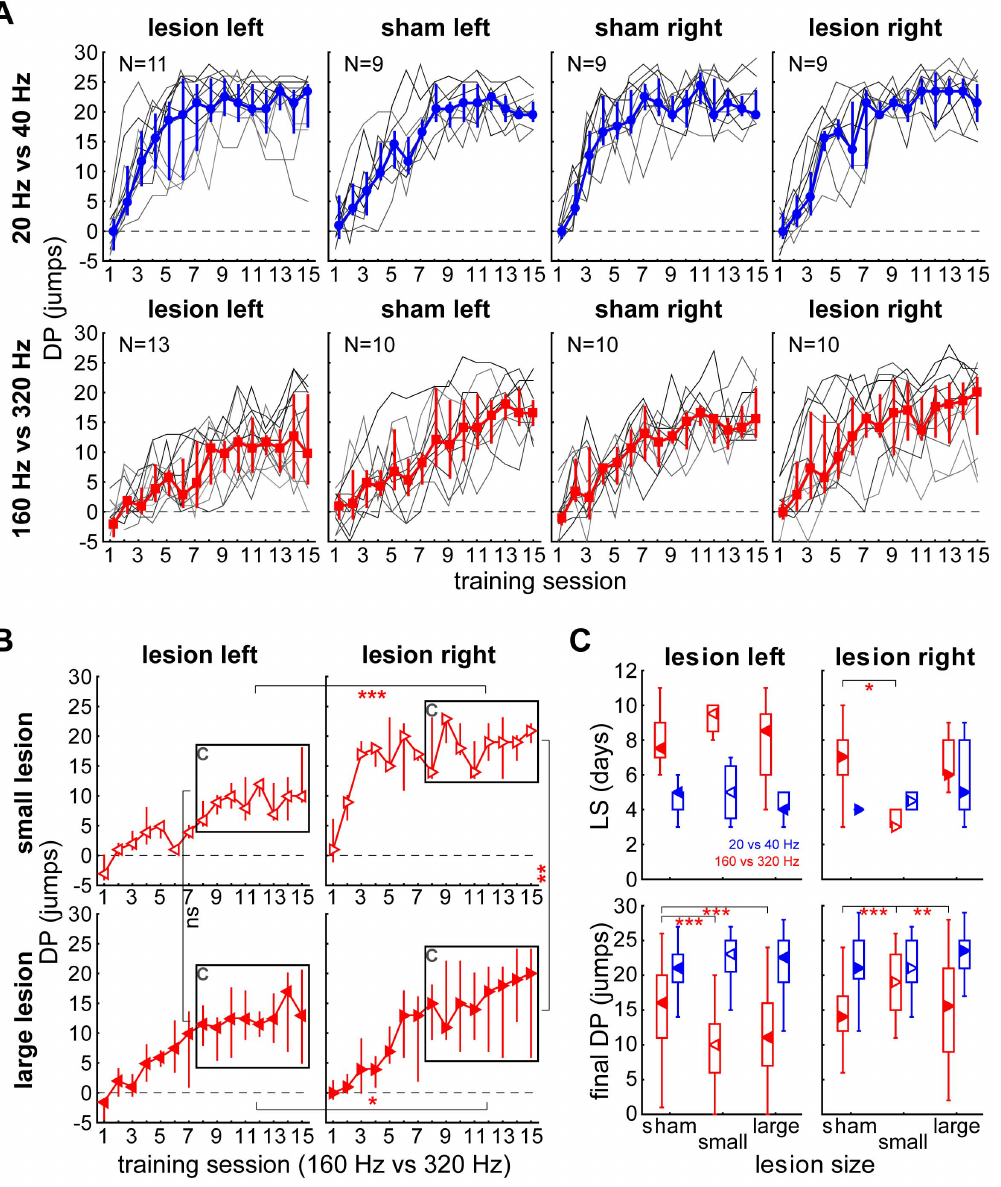
Figure 4. Effect of lesion size on discrimination performance (DP), final DP and learning speed (LS). A DP of all 83 animals (lines in shades of grey) over all training sessions in the 8 different groups with animals trained to discriminate periodicities of 20 Hz vs. 40 Hz (medians of data and quartiles in blue) and 160 Hz vs. 320 Hz (medians and quartiles in red). B Comparison of the DP of lesioned animals in 160 Hz vs. 320 Hz paradigm divided by lesion size (small lesion: open symbols; large lesions: solid symbols). Given are the DP median values and quartiles (whiskers), the boxes indicate the values used for the calculation of the final DP used in C. Between-group comparisons were carried out using Bonferroni-corrected Mann-Whitney U tests, p-level: *p , 0.05, **p , 0.01, ***p , 0.001. C Comparison of LS and final DP dependent on lesion side and size. Given are median values (arrows), quartiles (boxes) and the full range of values (whiskers) of LS (upper panels) and final DP (lower panels) for animals that were trained to discriminate periodicities of 20 Hz vs. 40 Hz (blue data) or 160 Hz vs. 320 Hz (red data) and received either a sham lesion or a left or right sided lesion of different extension. Between-group comparisons of lesion size effects were carried out using Kruskal-Wallis ANOVA, p-level: *p , 0.05, **p , 0.01, ***p ,